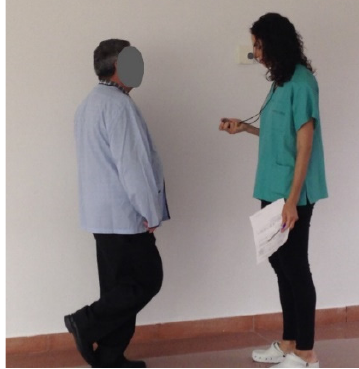
Figure 7. One Leg Balance Test (reproduced with permission from Erika Meléndez-Oliva 2020) [43].